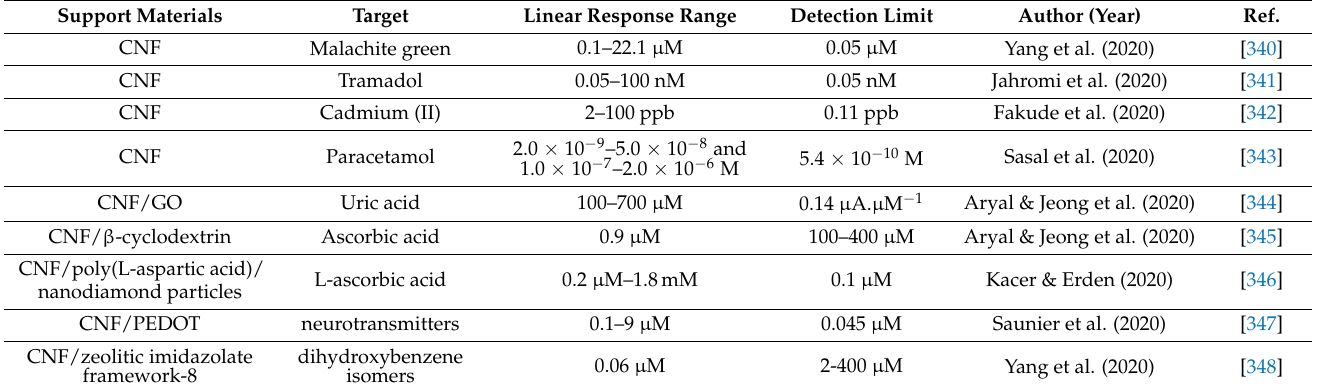
Table 8. Catalytic activity of the electrochemical sensors based on carbon